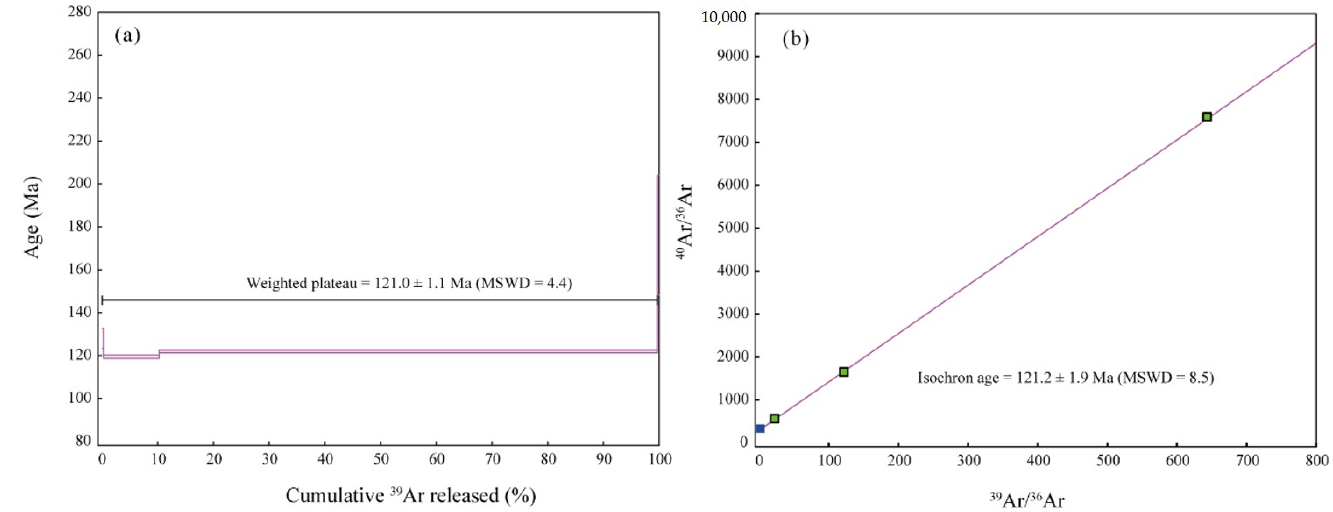
Figure 6. 39 Ar/ 40 Ar age spectra ( a ) and isochron ( b ) for alunite sample from the Saozhouhe deposit.